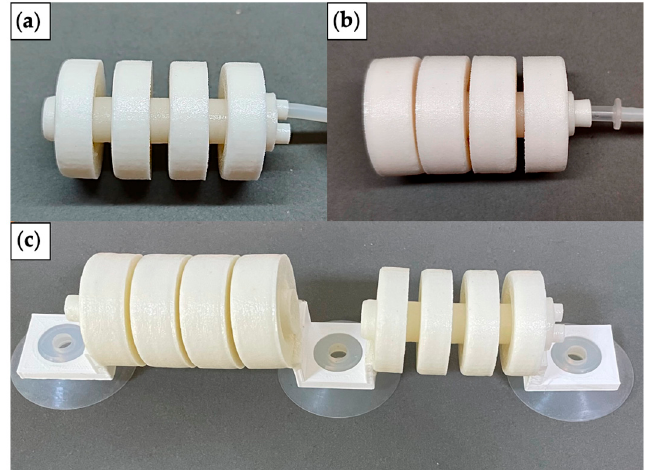
Figure 16. The fabricated models. ( a ) Single-channeled actuator. ( b ) Double-channeled actuator. ( c ) The robot prototype.